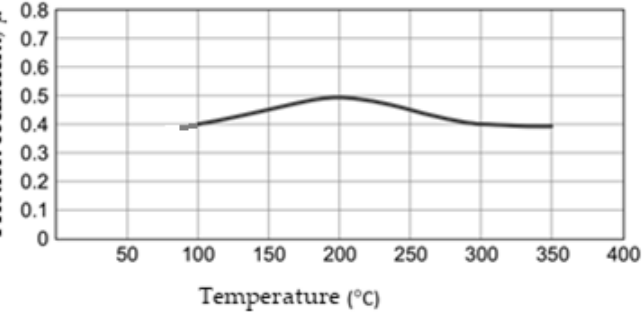
Figure 5. Variation of the friction coefficient of the composite/cast iron couple bound with a resin binder (reprinted/adapted with permission from ref. [13]. 2022, Elsevier).